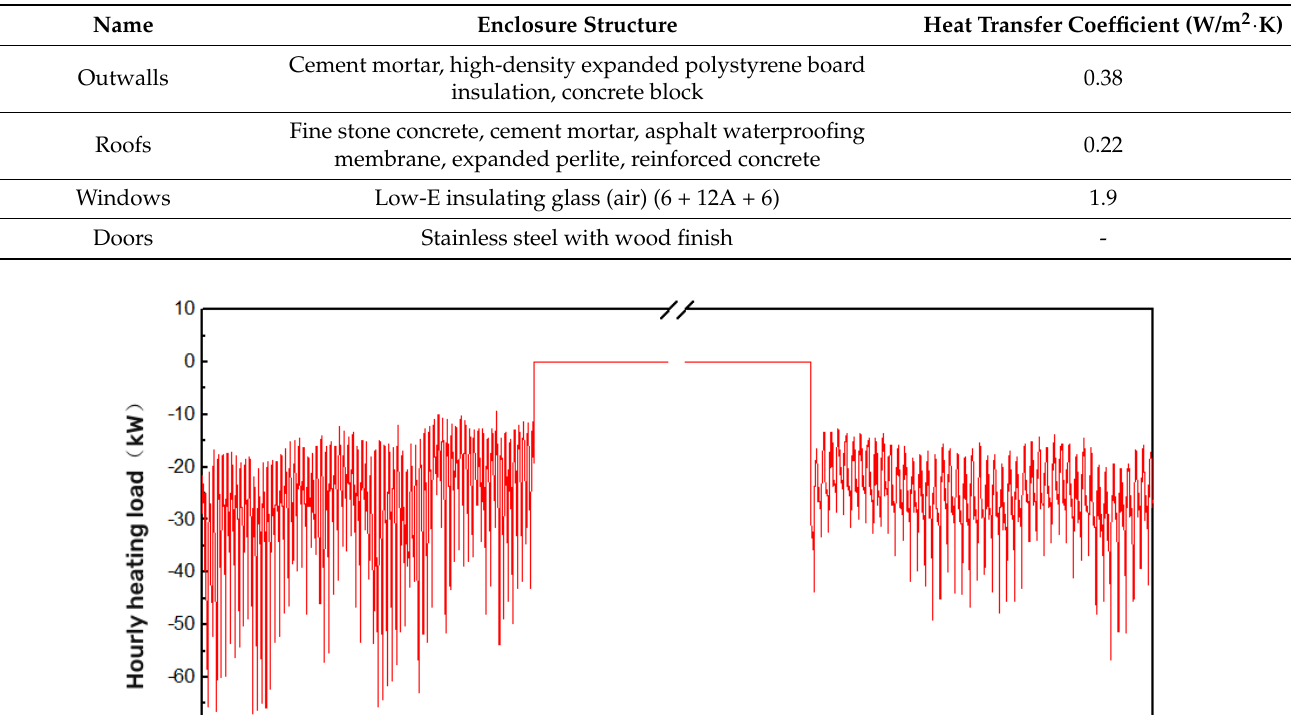
Table 1. Enclosure structures of the target building.